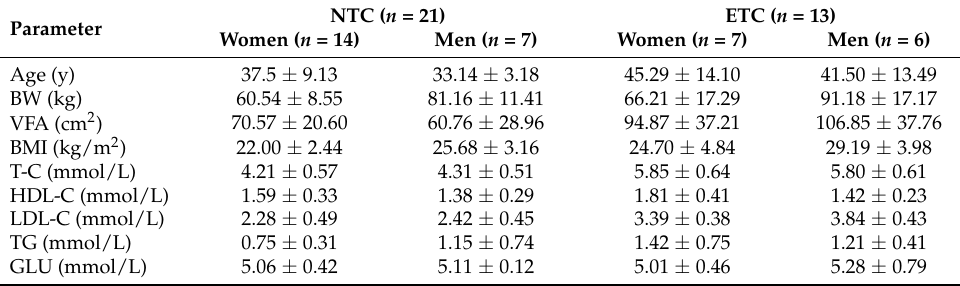
Table 2. Baseline characteristics of study participants.